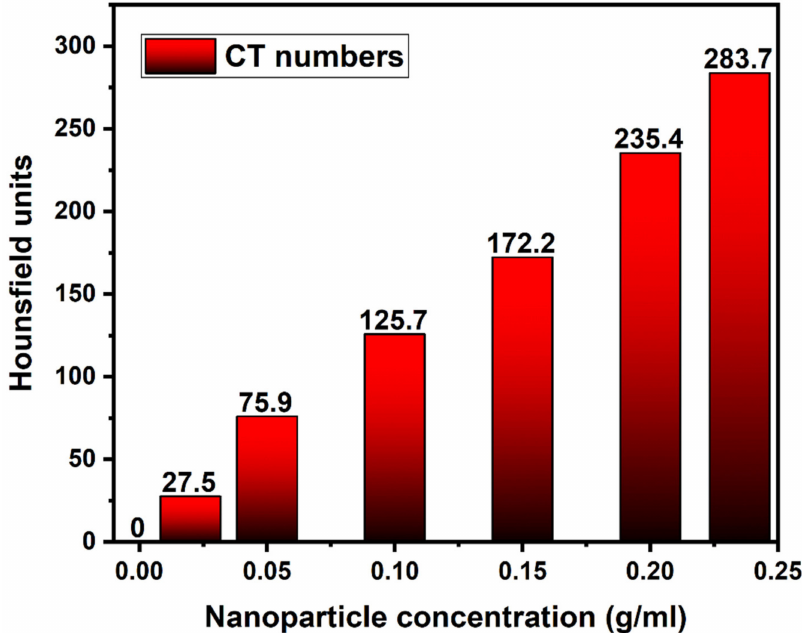
Figure 5. Computed tomography (CT) numbers of TiO 2 -NPs solution as a function of